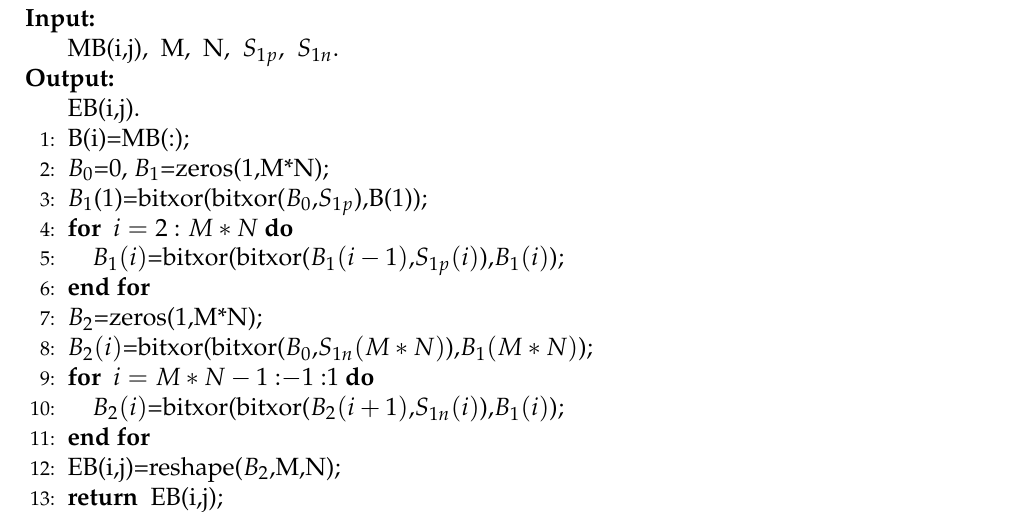
Algorithm 1 Diffusion processing(eg:image MB ( i , j )